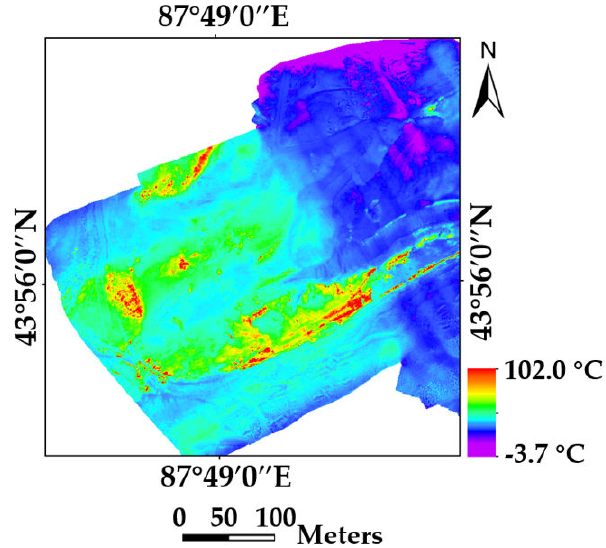
Figure 8. LST result based on UAV